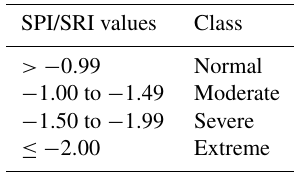
Table 1. Drought class classification and corresponding SPI values and SRI